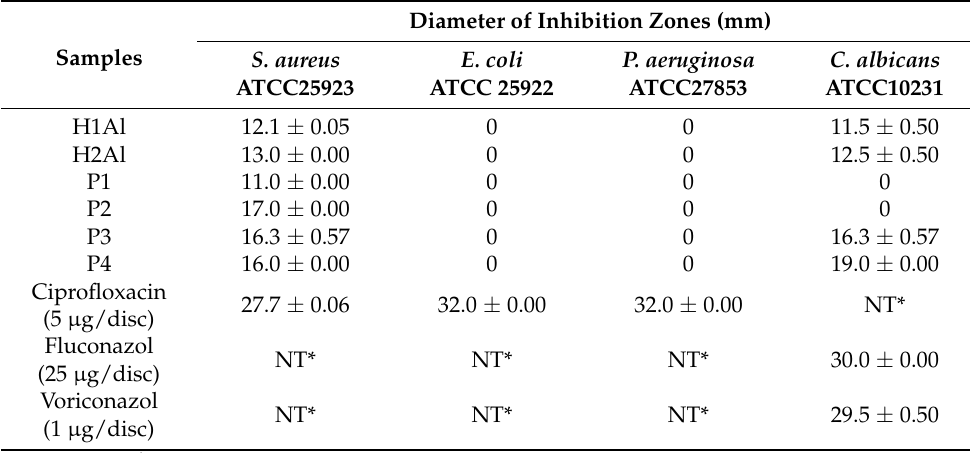
Table 7. Antibacterial and antifungal activities of the tested hydrogels.